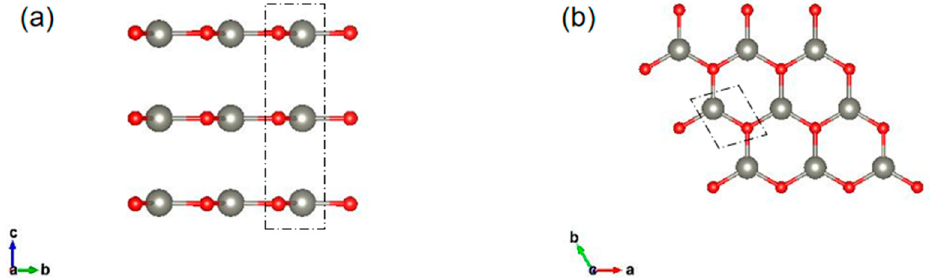
Figure 1. ( a ) Side view of the optimized geometrical structure of three-layer (3L) ZnO; ( b ) Top view of 2D graphite-like layered ZnO. The red and gray balls represent O and Zn, respectively.